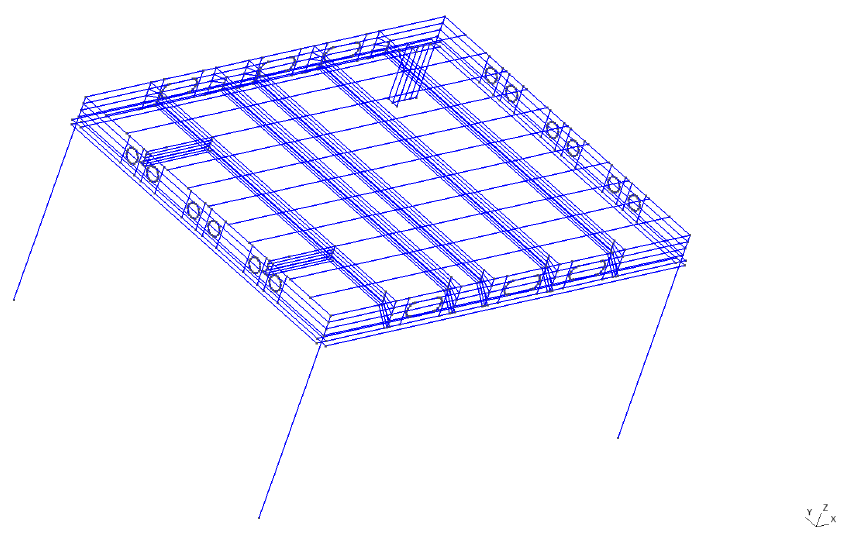
Figure 2. Geometry G 2